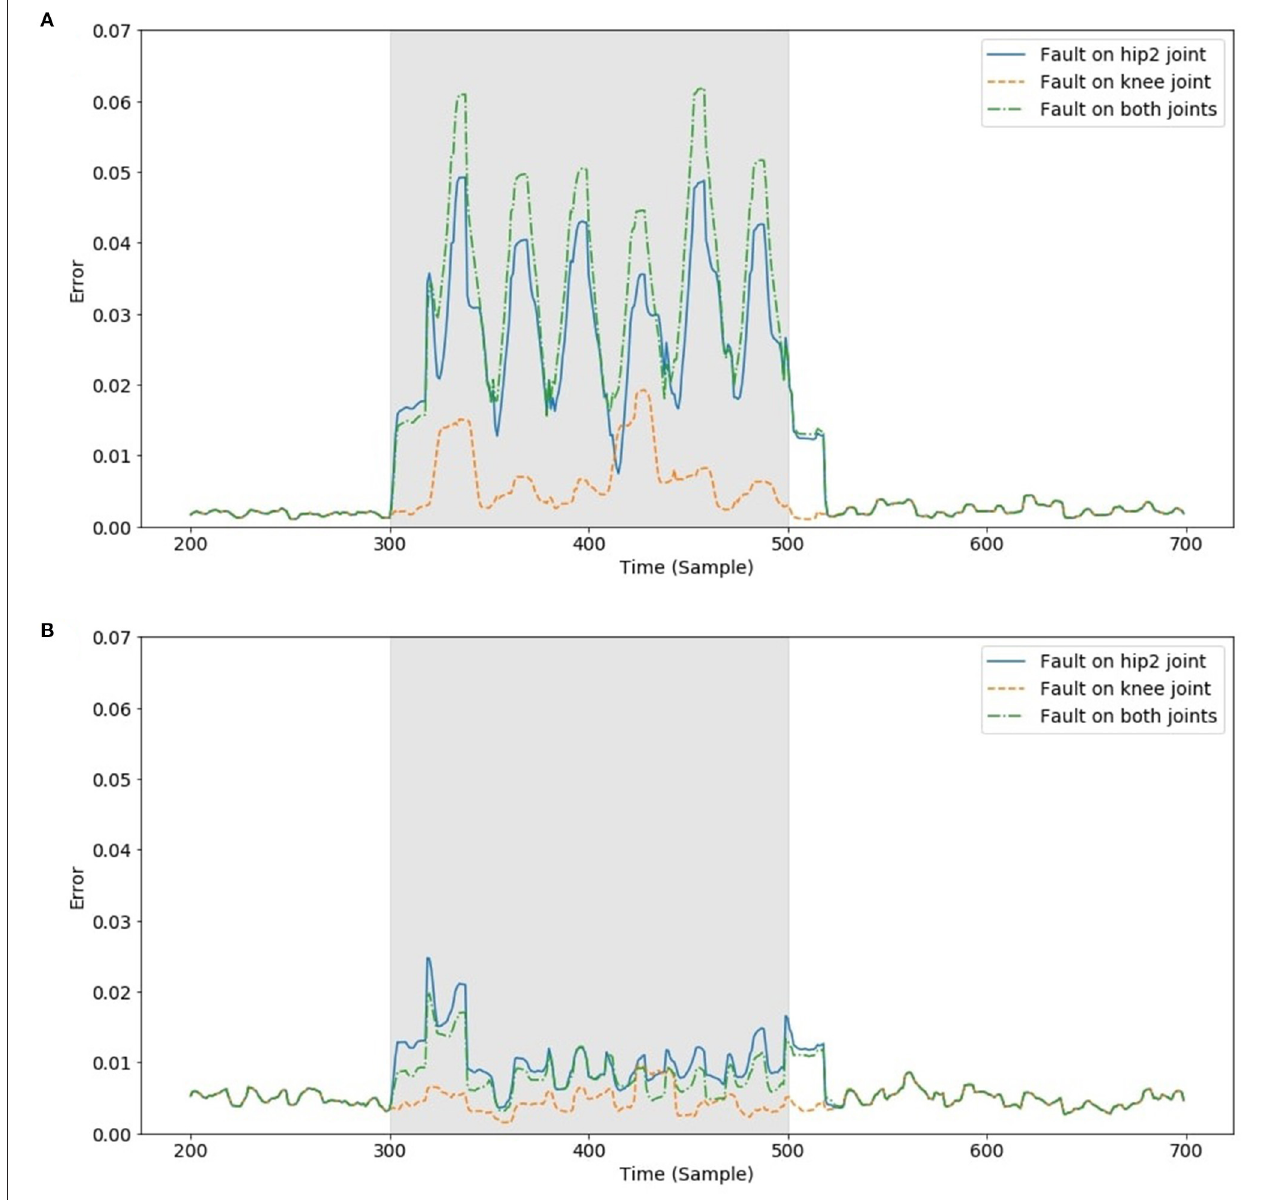
FIGURE 8 | Absolute error between actual and predicted GRF of the front right leg over time when a fault occurred on a specific joint (gray area) and the learning was performed without (A) and with faults (B) . The error signal was filtered using a sliding window of 20 samples to facilitate comparison.